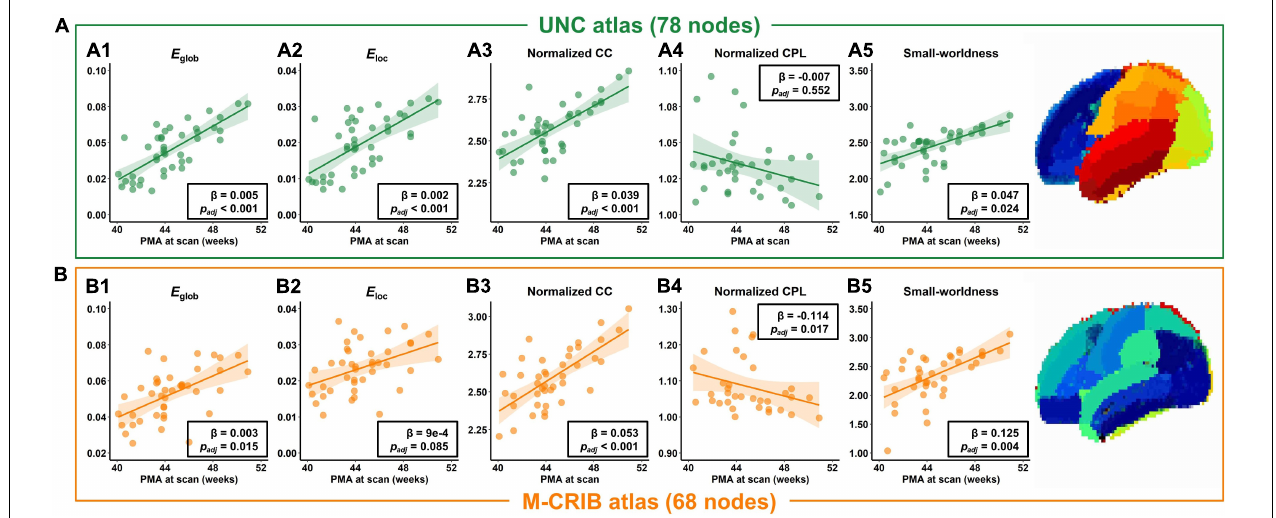
FIGURE 4 | Developmental trajectories of network measures in infants aged 0–3 months, in terms of the global efficiency ( E glob ), local efficiency ( E loc ), normalized clustering coefficient (CC), normalized characteristic path length (CPL), and small-worldness, based on the UNC atlas (A) or M-CRIB atlas (B) .